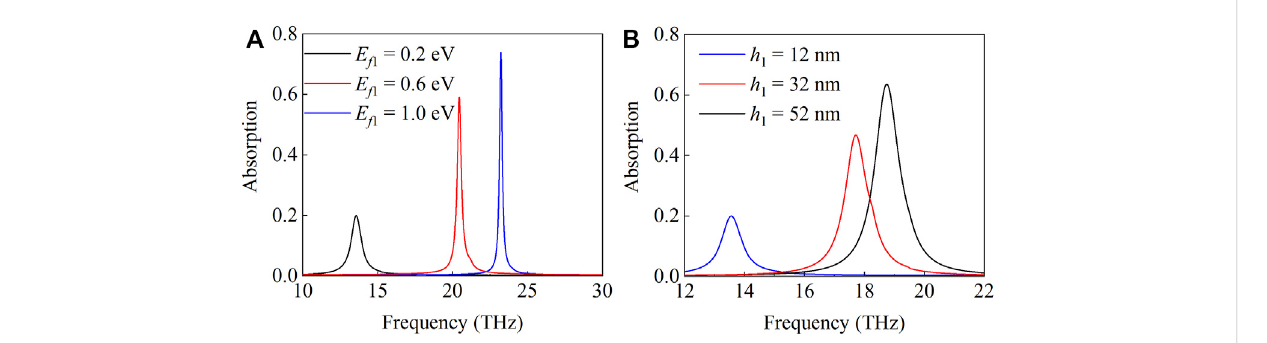
FIGURE 3 (A) Absorption spectra ofthemetamaterial with p =300 nm, w 1 = 100 nm, w 2 =90 nm, h 1 = 12 nm, h 2 =1,350 nm,and E f 2 =1 eVfor differentFermi levels E f 1 . (B) Absorption spectra of the metamaterial with p = 300 nm, w 1 = 100 nm, w 2 = 90 nm, h 2 = 1,350 nm, E f 1 = 0.2 eV, and E f 2 = 1 eV for different distances h